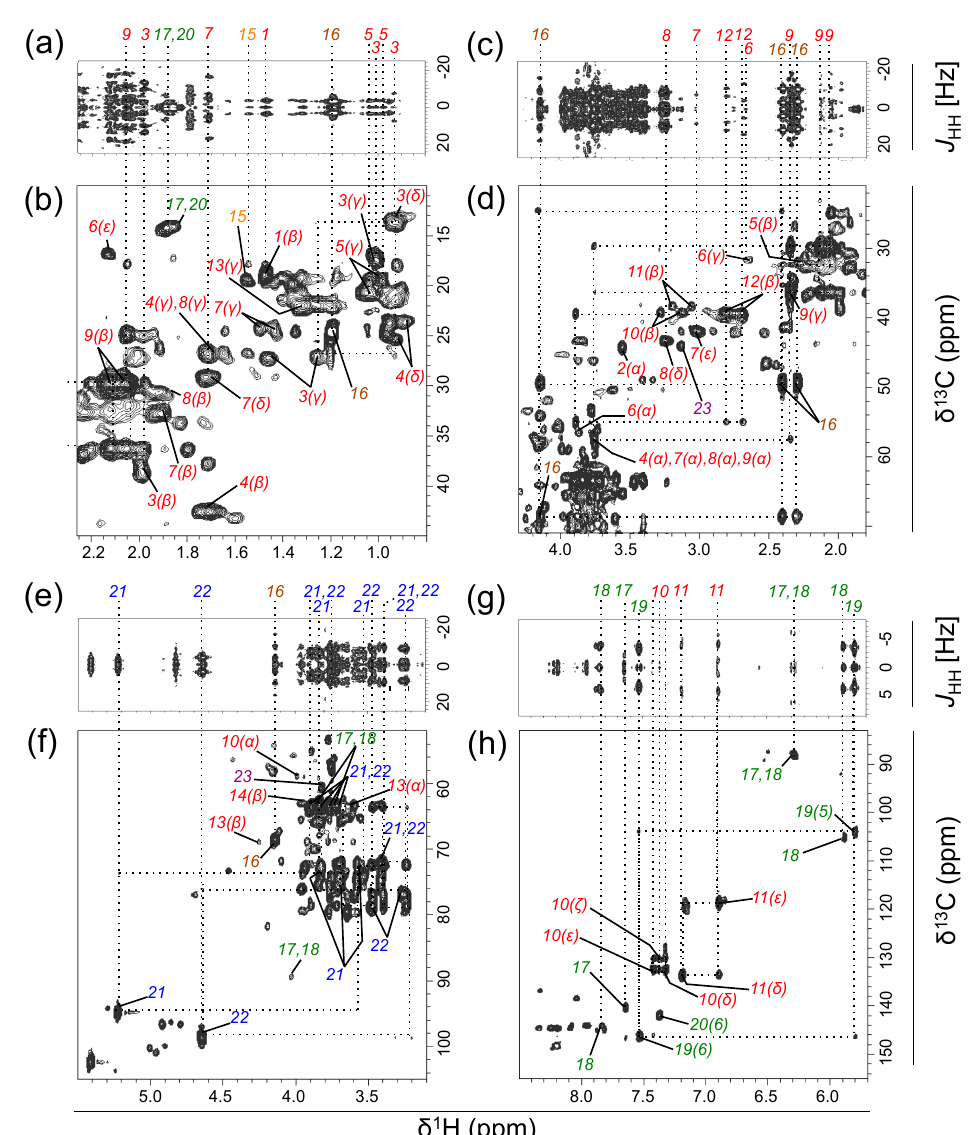
Figure 1. 13 C-decoupled two-dimensional 1 H ‒ 1 H J -resolved spectroscopy (2D- J res-dc) ( a , c , e , g ) and 1 H ‒ 13 C heteronuclear single quantum coherence ‒ total correlation spectroscopy (HSQC ‒ TOCSY) ( b , d , f , h ) spectra for metabolites transformed from 13 C 6 –glucose by a natural aquatic bacterial community (final concentration added, 500 µ M C) (Experiment 1). Signals were obtained after a 2-day incubation of a seawater sample collected from a coastal location. Spectra for the δ 1 H ( δ 13 C) ranged from 0.8 to 2.26 (10–45) ( a , b ); 1.8–4.3 (21–71) ( c , d ); 3.1–5.5 (52–105) ( e , f ); and 5.7–8.5 (83–155) ppm ( g , h ) are shown. Numbers indicate the corresponding metabolites listed in Table 1 (amino acids: red; dipeptides: orange; carboxylic acids: brown; nucleosides and nucleobases: green; carbohydrates: blue; amino alcohols: purple). Greek letters or numbers in parentheses for amino acids and nucleobases, respectively, denote the atom designation. In ( a ), an increased ( × 6) contour intensity magnitude was used for the δ 1 H range 1.6–2.26 ppm relative to the rest of the field (0.8–1.6 ppm). For the detailed analytical